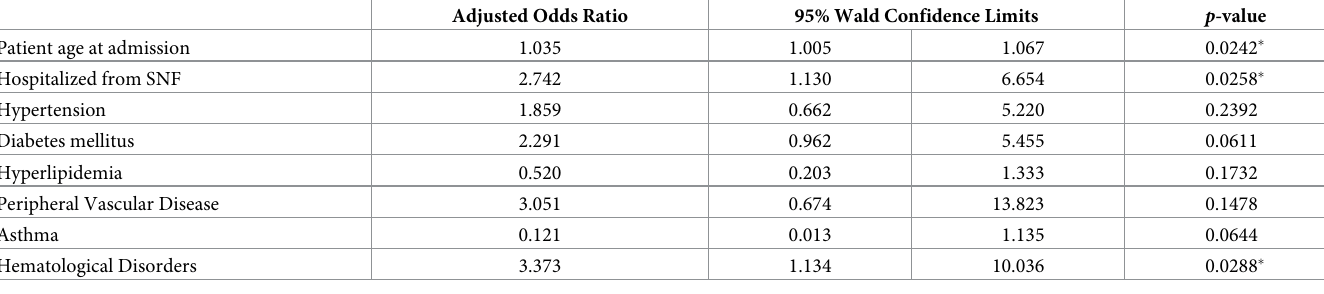
Table 4. Factors associated with in-hospital